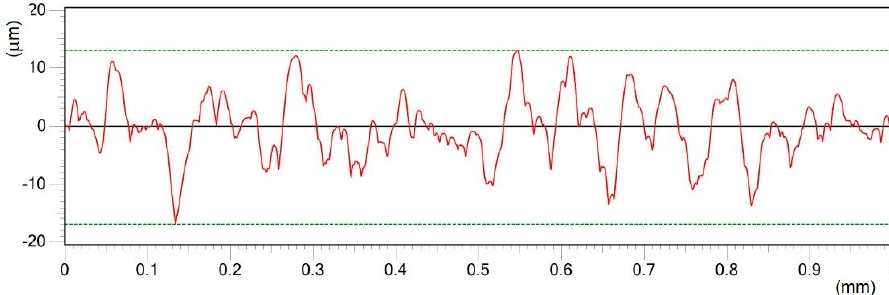
Figure 7. Roughness profile of surface B in Y direction treated by pulse energy of 0.4 mJ; Ra 4.37 μ m.